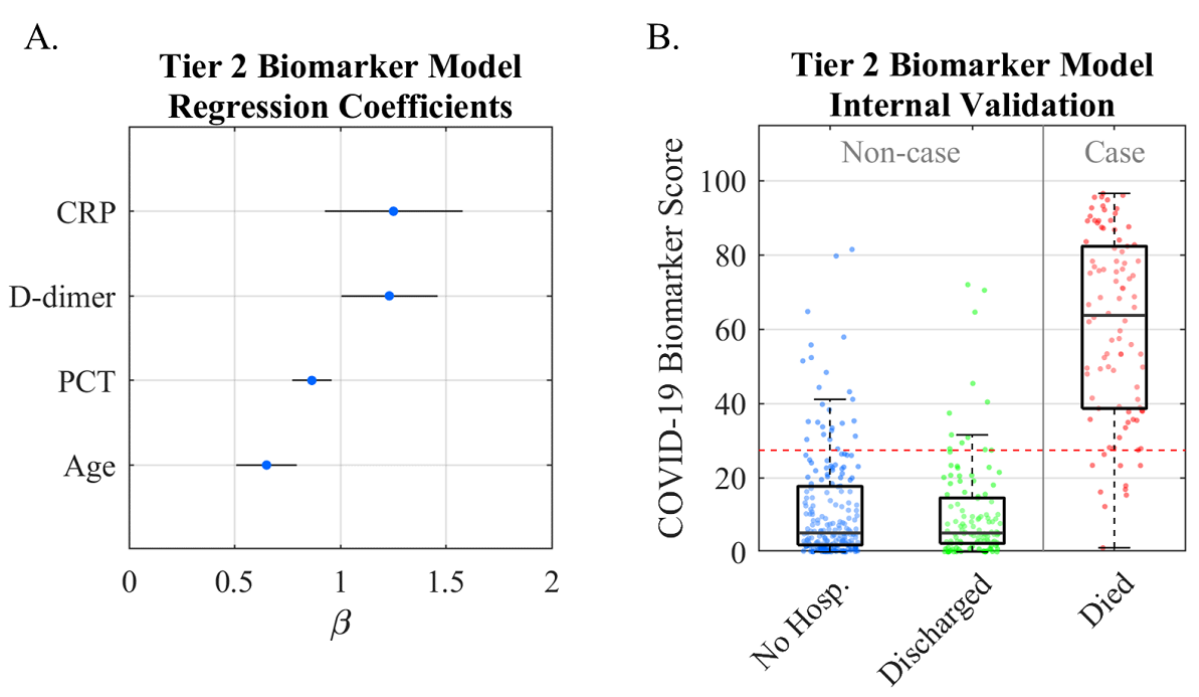
Figure 3. Validation of the Tier 2 Biomarker Model. A. Lasso logistic regression coefficients revealing the relative importance of predictors in generating the score. B. The box/scatter plot from internal validation shows Tier 2 Biomarker Scores for the three patient outcomes. A cutoff score of 27 (horizontal red dotted line) balances sensitivity and specificity for “Noncase” vs “Case” patients (vertical gray line) COVID-19: coronavirus disease; No Hosp.: patients who were not